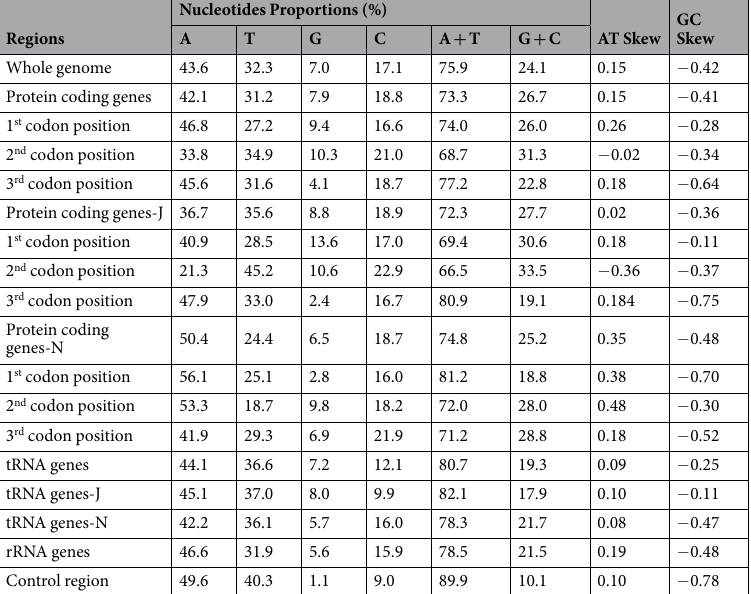
Table 3. Nucleotide composition of the Aposthonia borneensis